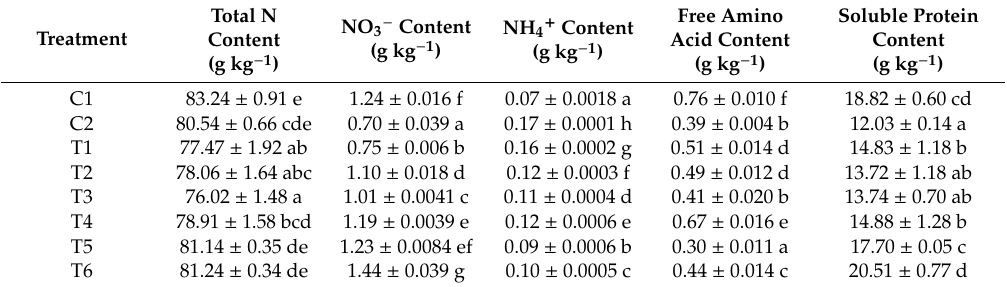
Table 2. E ff ects of IAA on total N content and N assimilation compounds under Cu stress. Treatment